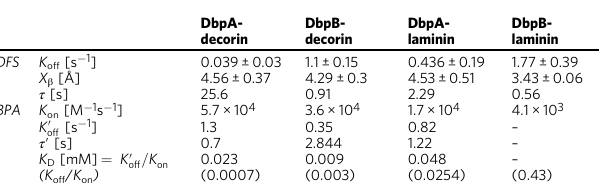
, arising from the decaying off